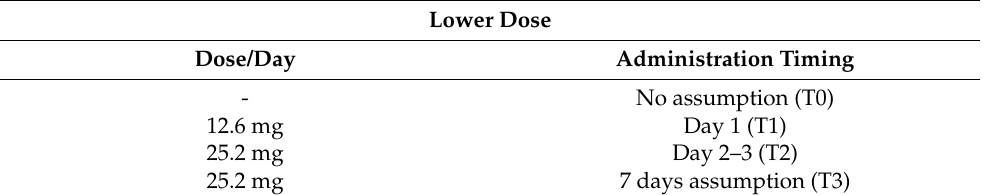
Table 6. Doses and timing of sulforaphane (SFN) administrations in the first healthy volunteer enrolled (HV1).